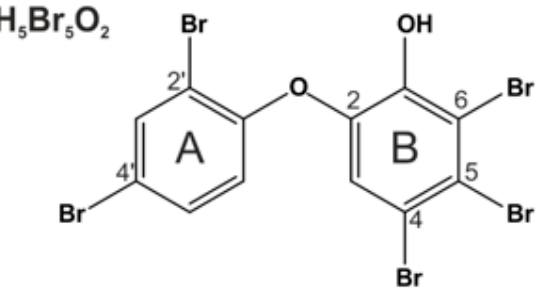
Figure 6. P01F08 ( 1 ) belongs to class I according to the nomenclature of Calcul et al., 2009. The A ring comprises two bromine substituents in 2 ′ and 4 ′ position, linked by an ether bond to ring B comprising three bromine substituents at position 4,5,6, and a hydroxy group in ortho position. 13 C NMR data for compound P01F08 (compound 3 in Fu and Schmitz.,1996) were